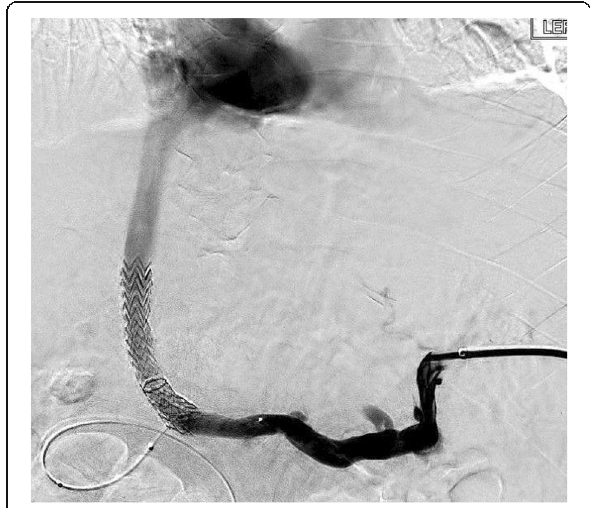
Fig. 5 Splenic venogram showing a deployed Viatorr CX stent within PV, improved caliber of the PV and SV and resolution of